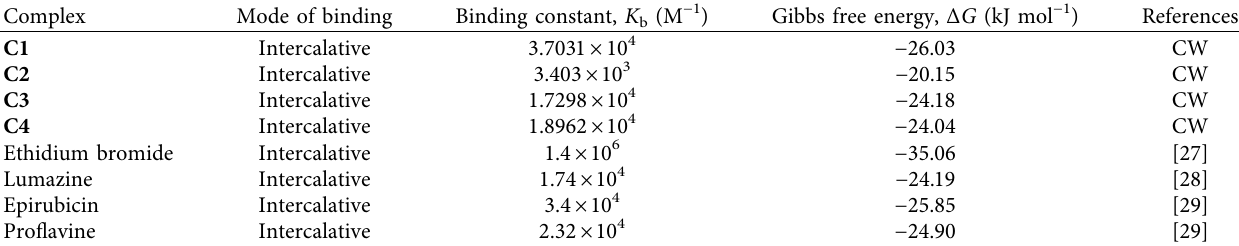
Table 4: Comparison of binding constants ( K b ) and Gibbs free energy values for the complexes-DNA interactions derived from UV spectrophotometric data at pH 7.21 with other reported